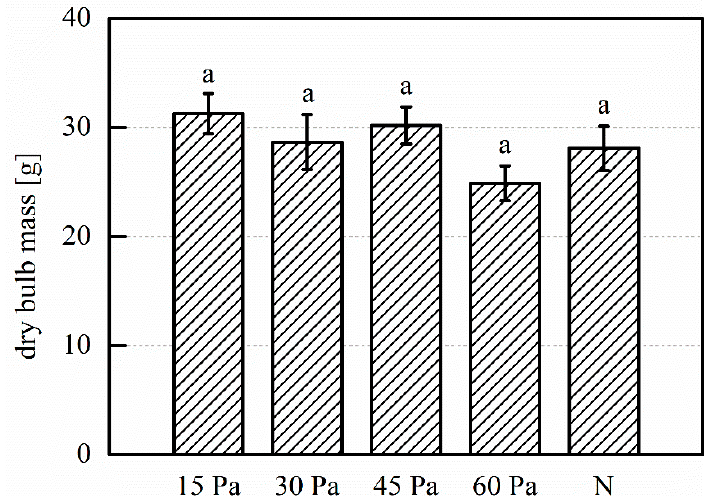
Figure 10. Mean mass of dried garlic bulbs of garlic plants grown from treated and untreated cloves. 15 Pa, 30 Pa, 45 Pa, 60 Pa: plasma treatments at the indicated working pressure; N: untreated control. Number of replications: n = 3 (of five samples each, total 15 samples). Error bars indicate standard error. Different letter labels indicate statistically significant differences ( p < 0.05).